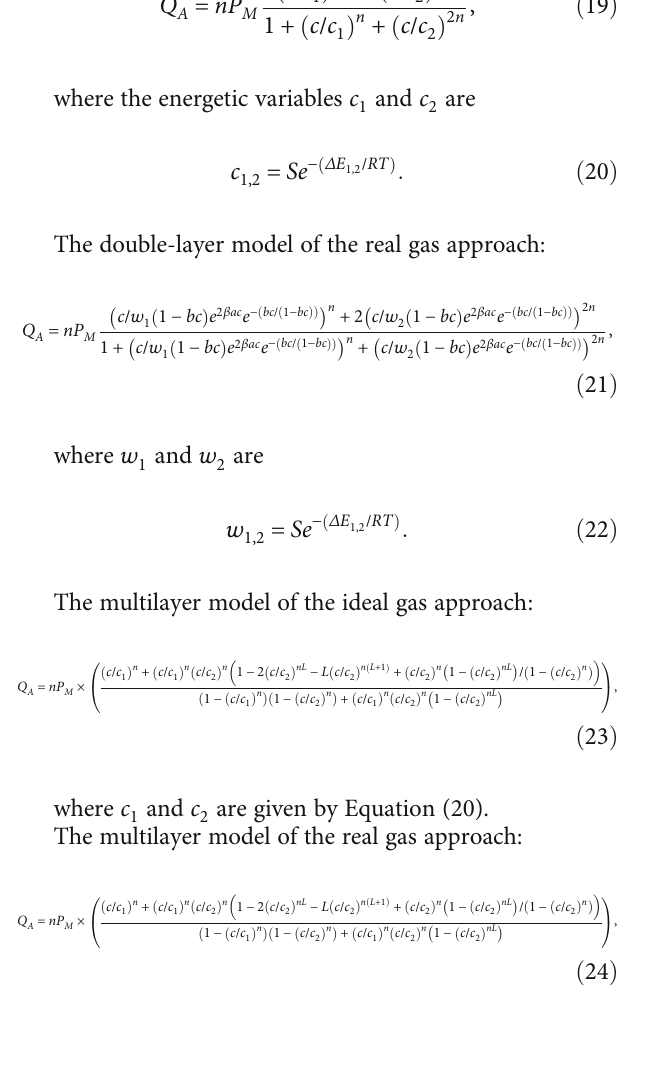
on the two porphyrins 3